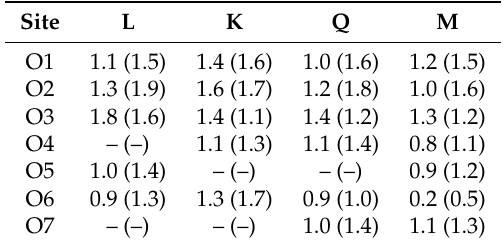
Table 1. Running coordination number (RCN) of the studied Oxygen sites of the different flavonoids as obtained from MD noVS and MD VS (in parentheses). See Figure 2 for atom labeling.